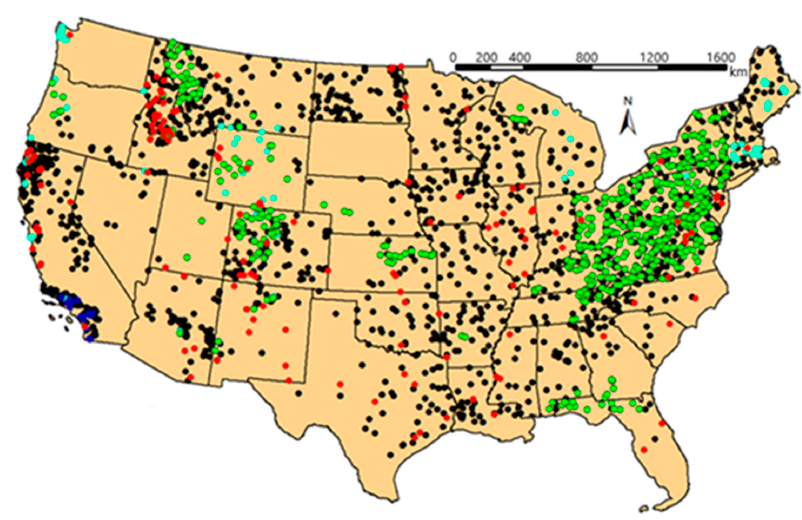
Figure 1. Distribution of D50 data points from five sources across the contiguous U.S. Dots with different colors in the figure represent different D50 data sources. Table 1. D50 data sources with other hydrological parameters.